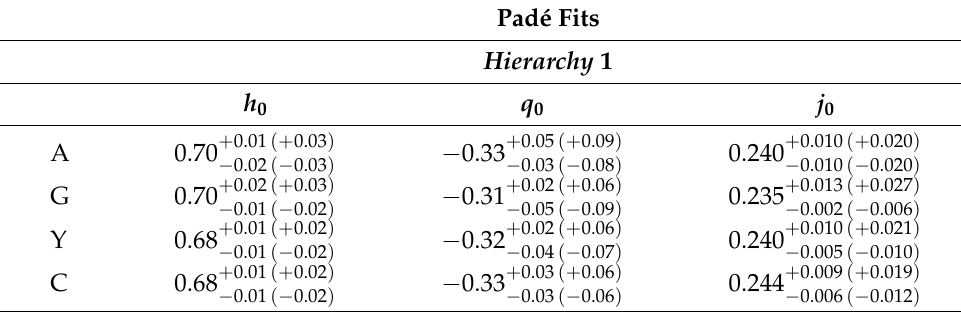
Table 5. Cosmographic best fits and 1– σ (2– σ ) errors from Padé expansions labeled as hierarchy 1 . Letters A, G, Y, and C indicate Amati, Ghirlanda, Yonetoku, and Combo correlations, respectively.